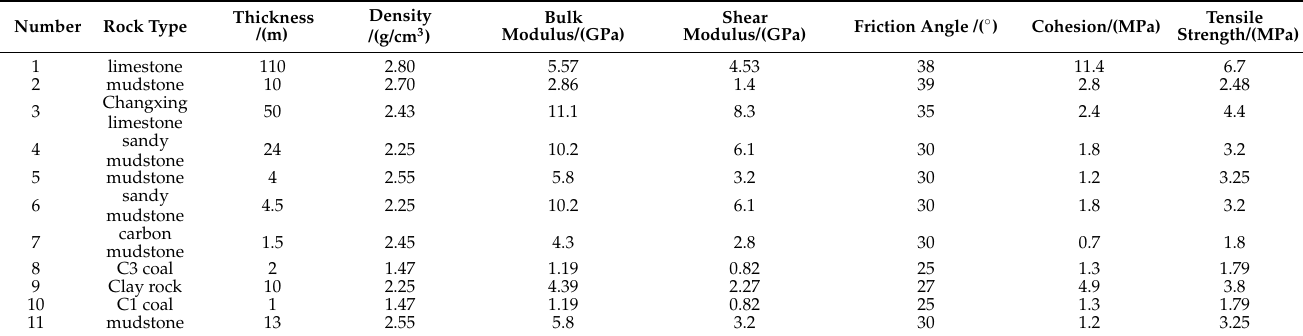
Figure 5. UDEC calculation model (angle 0°). Table 6. Physical and mechanical parameters of rock